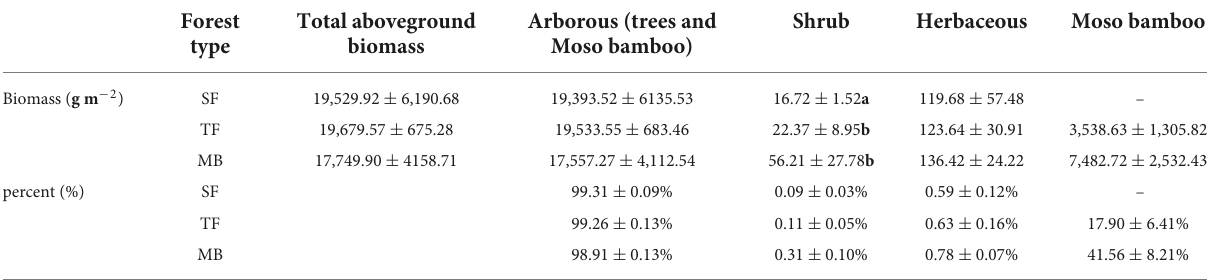
TABLE 4 Effect of the Moso bamboo invasion on aboveground biomass (mean ± SD; N = 3 in each group) in each layer and their contribution to the total aboveground biomass. Forest Total aboveground Arborous (trees and type biomass Moso bamboo)